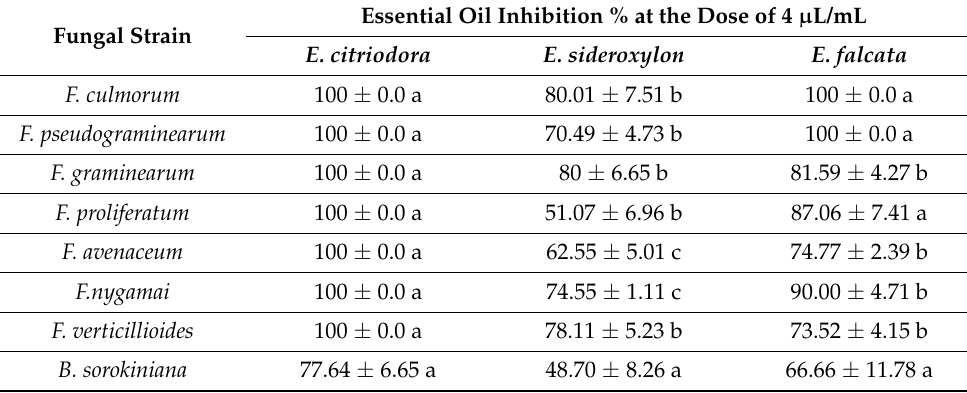
Table 7. Antifungal activity of E. citriodora , E. sideroxylon , and E. falcata essential oils. Fungal